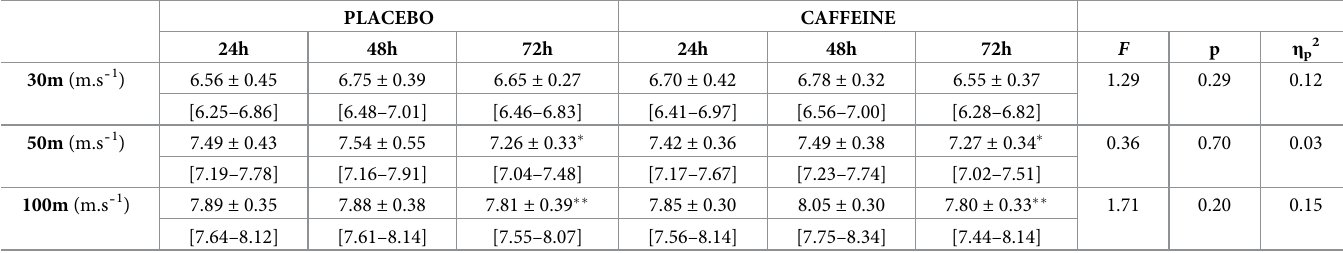
Table 2. Sprint performance at 24, 48 and 72 h later a half-squat exercise with placebo or caffeine ingestion.